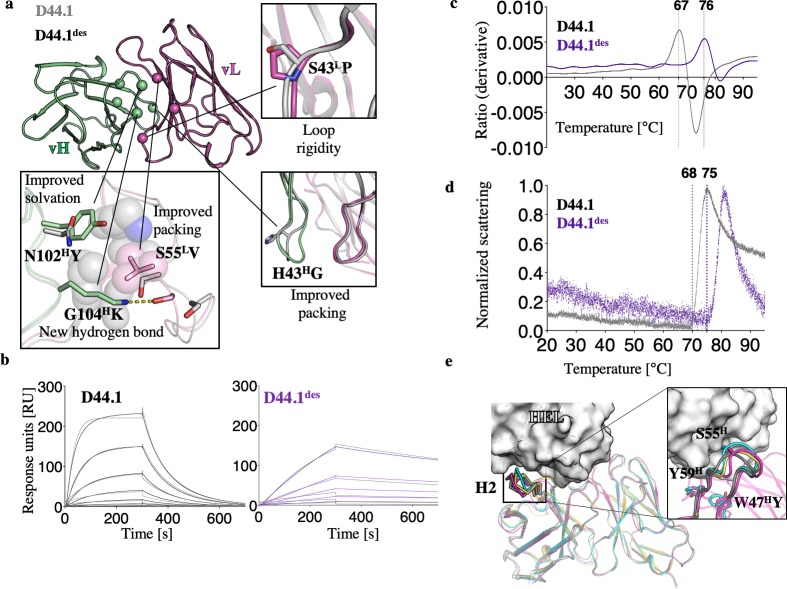
Gains in affinity, stability, and aggregation resistance through vL-vH interface design guided by deep mutational scanning.(a) Comparison of the starting anti-lysozyme antibody D44.1 and the crystal structure of design D44.1des (PDB entries: 1MLC and 6GC2, respectively) showed improved interactions across the interface and likely increased backbone rigidity. (b) SPR kinetic analysis of hen egg-white lysozyme (HEL) binding with threefold dilutions of HEL from a maximal concentration of 333 nM for D44.1 and 111 nM for D44.1des (kinetic fits shown in gray). D44.1 exhibited ka = 1.5 * 105 M-1s-1, kd = 0.021 s-1, and KD = 137 nM. D44.1des exhibited ka = 5.3 * 104 M-1s-1, kd = 7.9 * 10−4 s-1, and KD = 15 nM (c & d) Thermal denaturation and temperature of aggregation onset, respectively, of D44.1 and D44.1des formatted as Fabs using microscale thermophoresis. (e) A potential molecular explanation for improved affinity. The unbound (cyan) and bound (gray) structures of D44.1 (PDB entries: 1MLB and 1MLC, respectively) exhibit a different H2 backbone conformation; the former sterically hinders lysozyme binding. The high-affinity anti-lysozyme antibody F10.6.6 in its unbound form (PDB entry: 2Q76; orange) and D44.1des (pink) are similar to one another and to the bound conformation of D44.1 and are compatible with binding HEL. (inset) a closeup of the H2 backbone conformation revealing that the D44.1 H2 backbone (cyan) sterically overlaps with lysozyme, whereas all the other backbone conformations are compatible with lysozyme binding. The Trp47HTyr mutation in D44.1des alters packing at the base of CDR H2 and may induce the observed conformational change in the design.